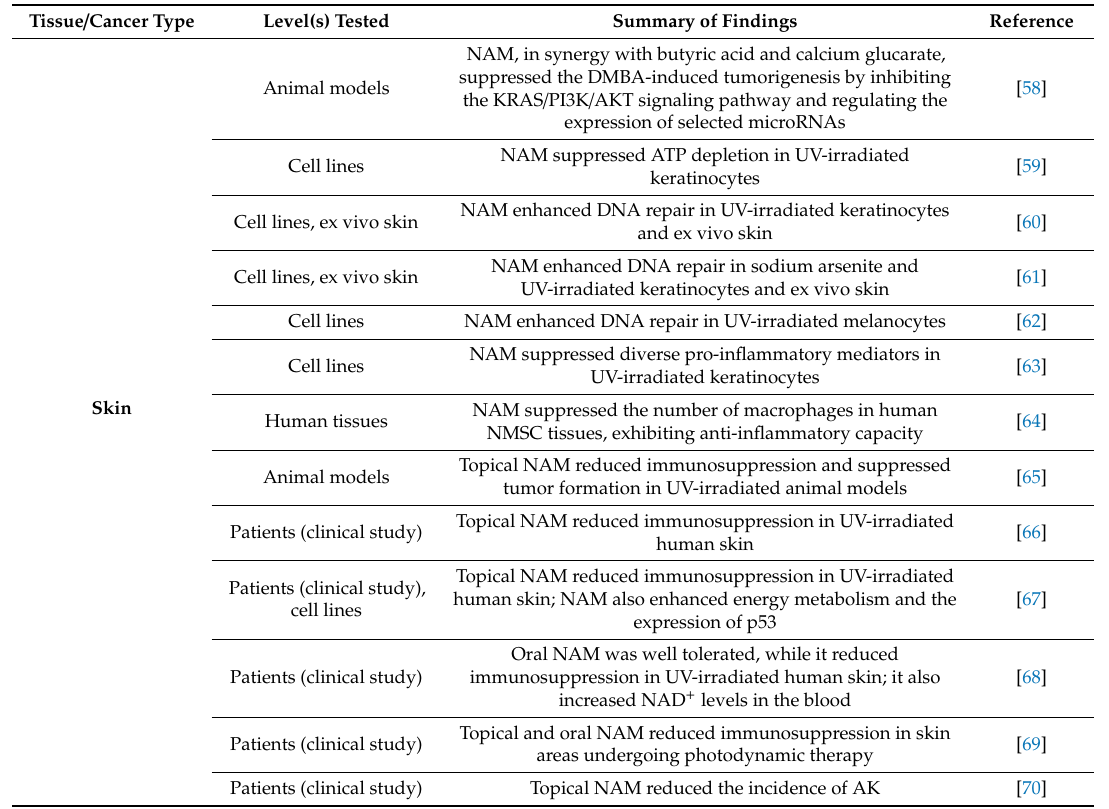
Table 1. Summary of the evidence (preclinical / clinical) that supports the role of nicotinamide (NAM) in cancer